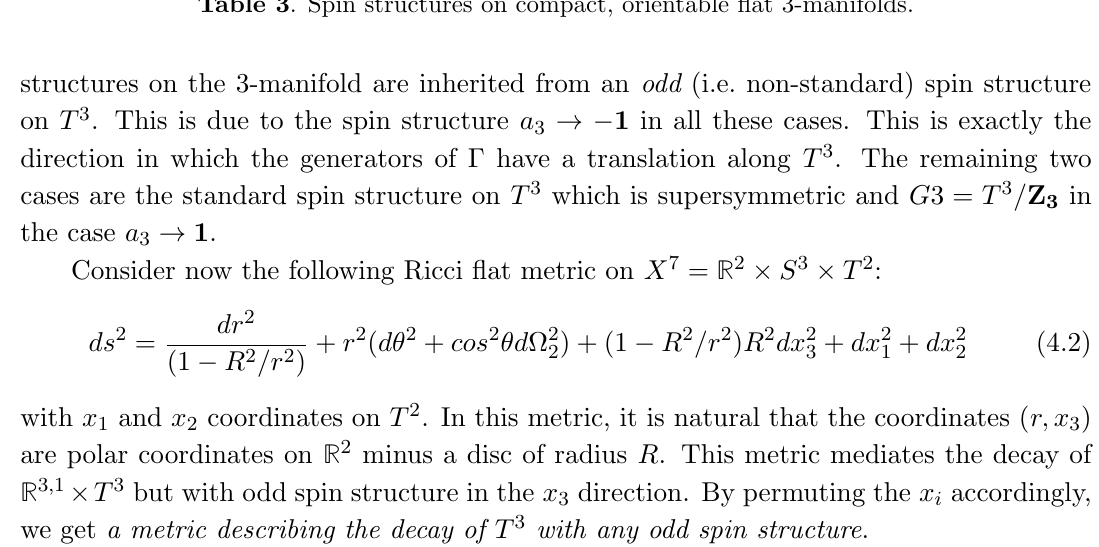
Table 3 . Spin structures on compact, orientable (cid:13)at